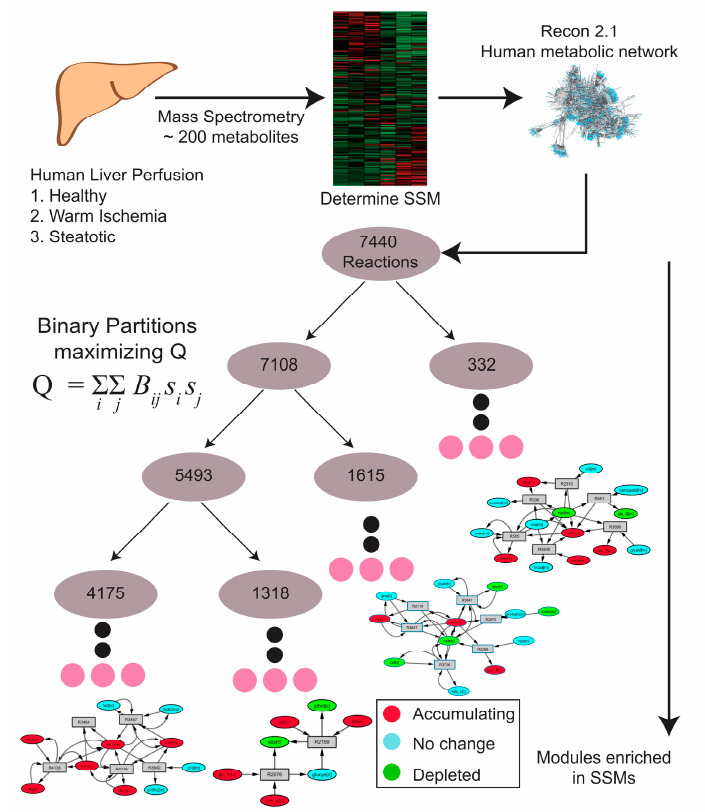
Figure 2. Schematic of the MMA workflow starting from sample collection to metabolomics analysis, to the partitioning of metabolomics-based weighted metabolic network using Newman’s algorithm, to discovering metabolic modules enriched with SSMs.